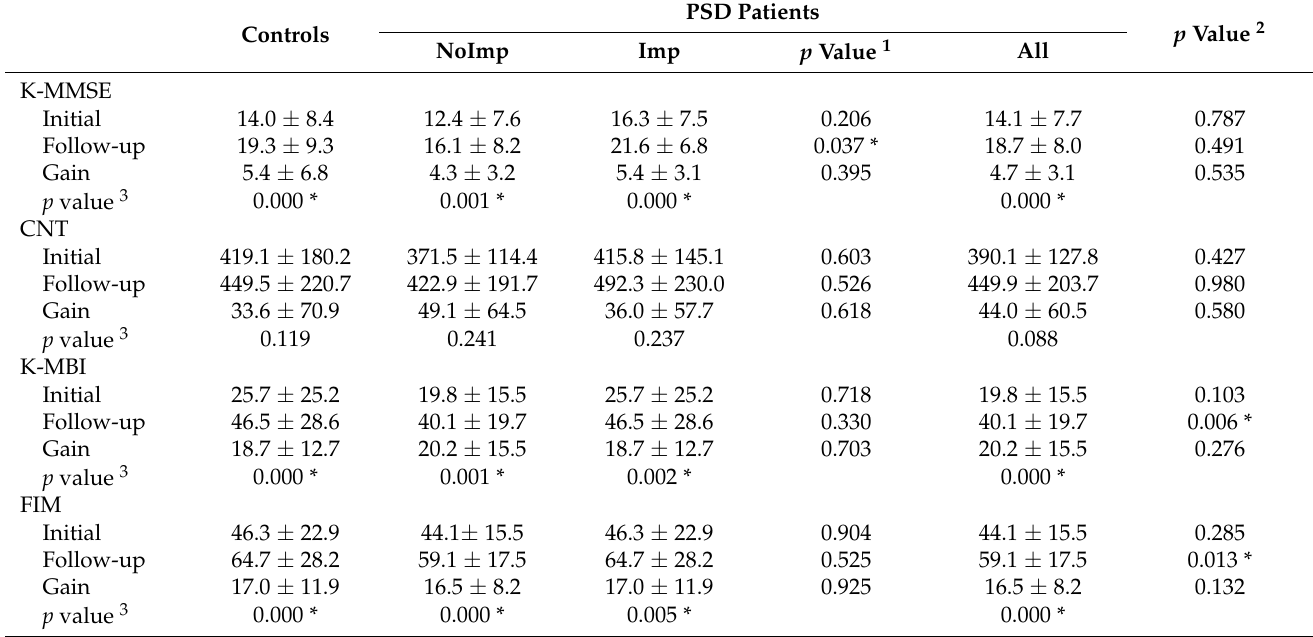
Table 2. Initial and follow-up results of all cognitive and functional tests for controls and PSD patients.